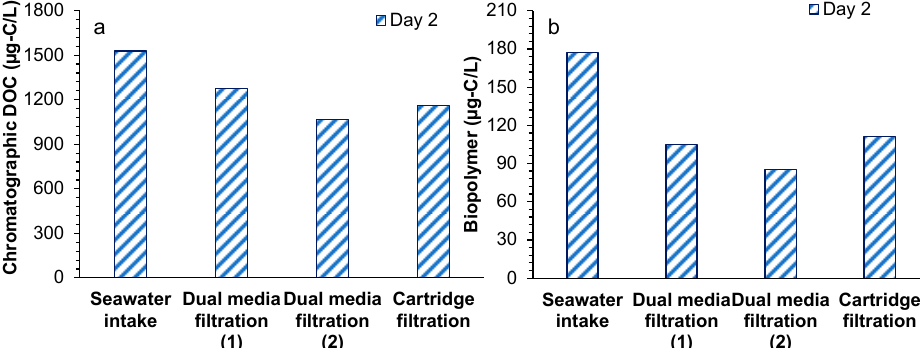
Figure 4. ( a ) Chromatographic dissolved organic carbon and ( b ) biopolymer concentrations during the RO pretreatment processes of the SWRO desalination plant, as measured by LC-OCD.